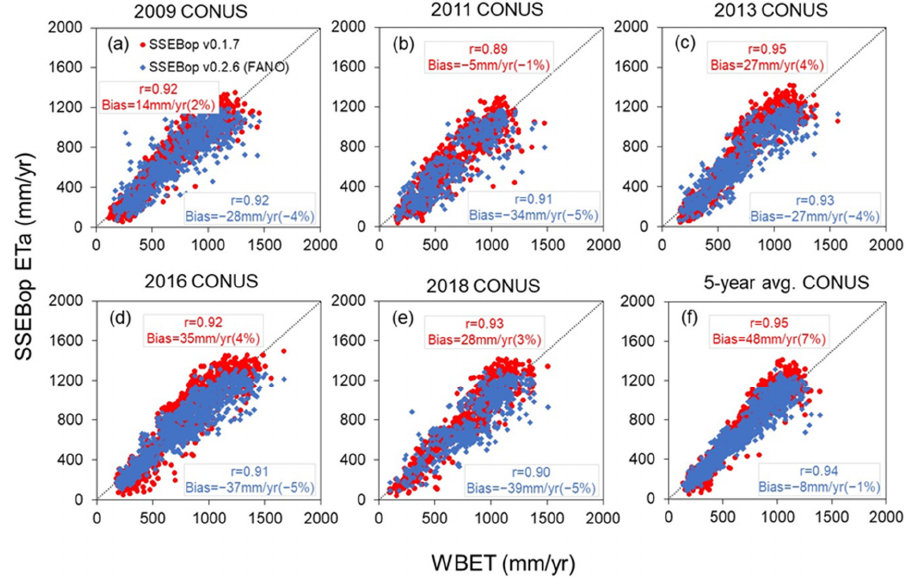
Figure 7. Comparison of annual ETa from SSEBop v0.1.7 and SSEBop v0.2.6 (FANO) with water balance (WBET) across HUC8s in the conterminous United States (CONUS). Subfigures ( a ), ( b ), ( c ), ( d ), ( e ), and ( f ) show the ET comparisons for water years 2009, 2011, 2013, 2016, 2018, and 5-year average, respectively. Table 3. Summary of HUC8 ETa comparison between SSEBop v0.1.7 and SSEBop v0.2.6 (FANO) with water balance (WBET) for 5-year average (5-y avg.) and individual years. The Pearson correlation coefficient (r) shows the degree of association between the two versions of SSEBop and WBET for the six regions and CONUS.